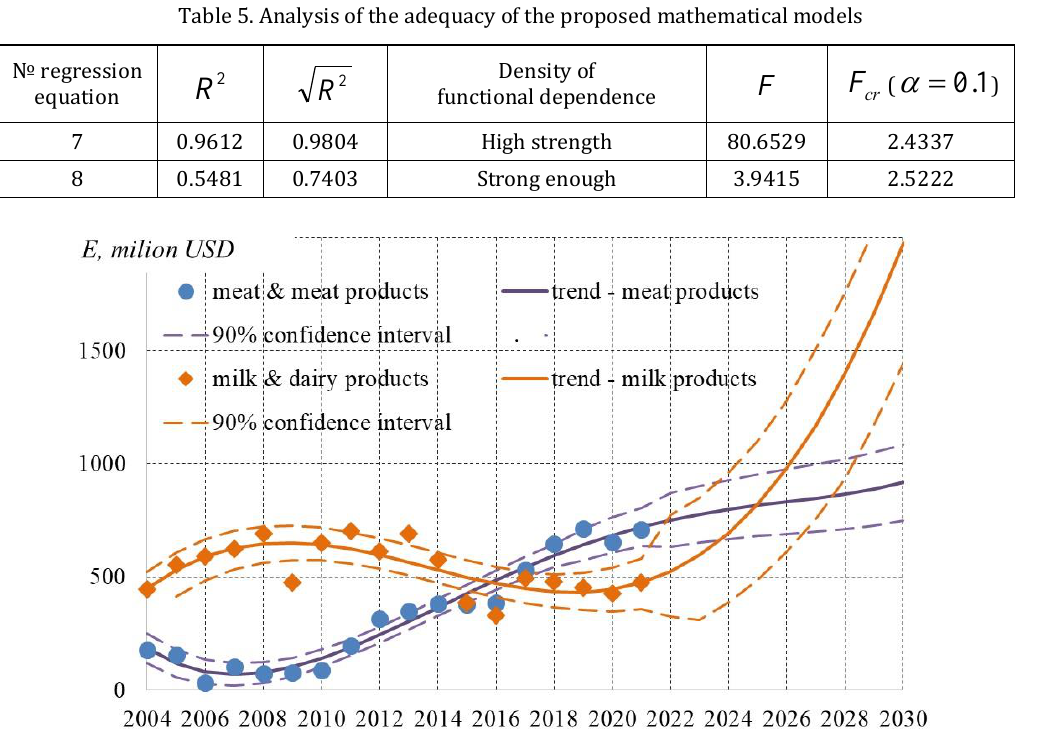
Fig. 6. Dynamics of Ukraine's exports, physical volume, in million